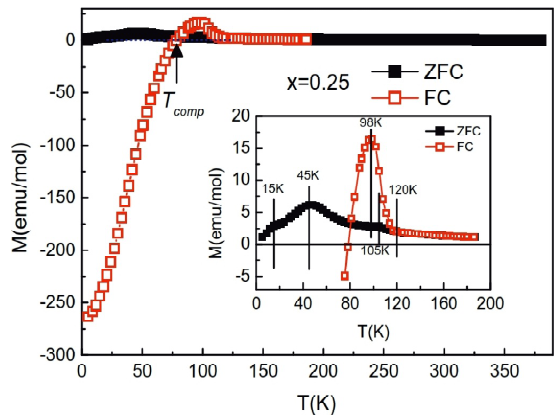
Fig. 12. Temperature dependent magnetization curves for Bi Ca Mn Cr O under ZFC and FC 0.3 0.7 0.75 0.25 3 modes respectively. The inset is the enlarged part of M ( T ) curves. Reproduced from [75] with permis- sion from Elsevier.